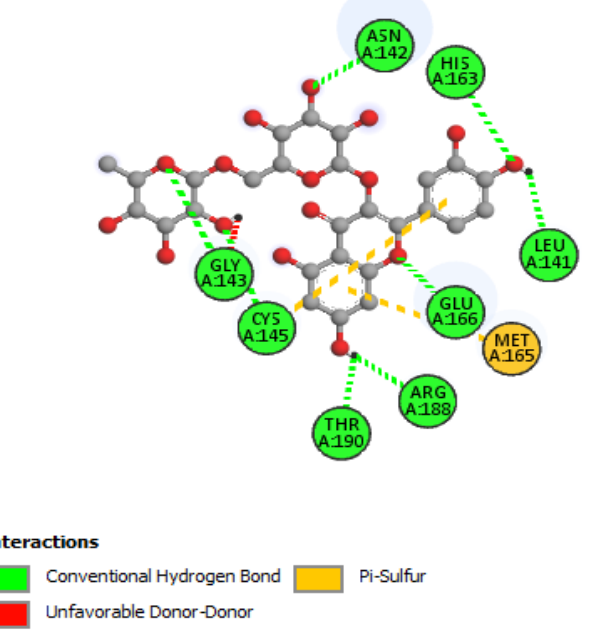
Figure 3. 2D interactions of rutin with Mpro.